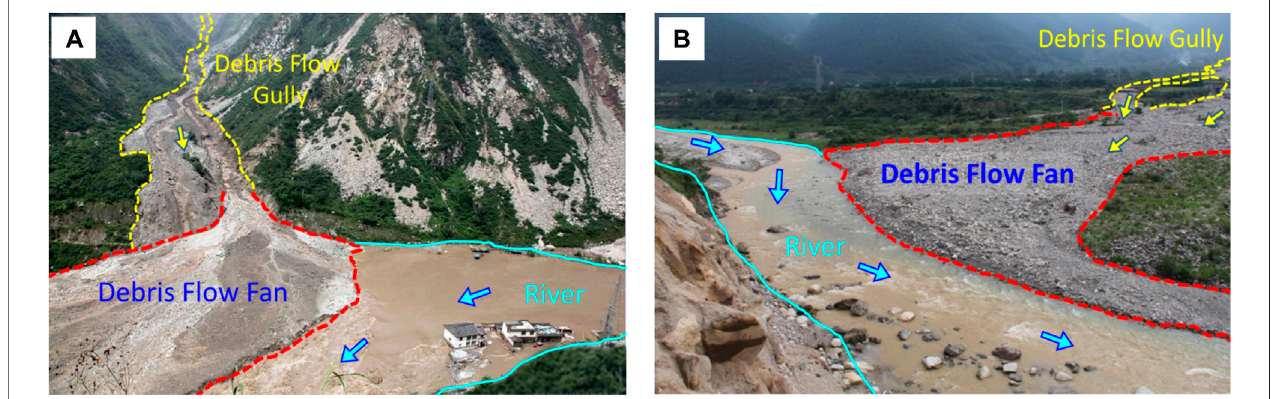
FIGURE 4 | (A) On July 3, 2011, the debris fl ow in Gaojiagou Gully, Yinxing Township, Wenchuan County, Sichuan Province blocked the Minjiang River. (B) On June 26, 2020, a debris fl ow in Yihai Town, Mianning County, Sichuan Province blocked Caogu River..